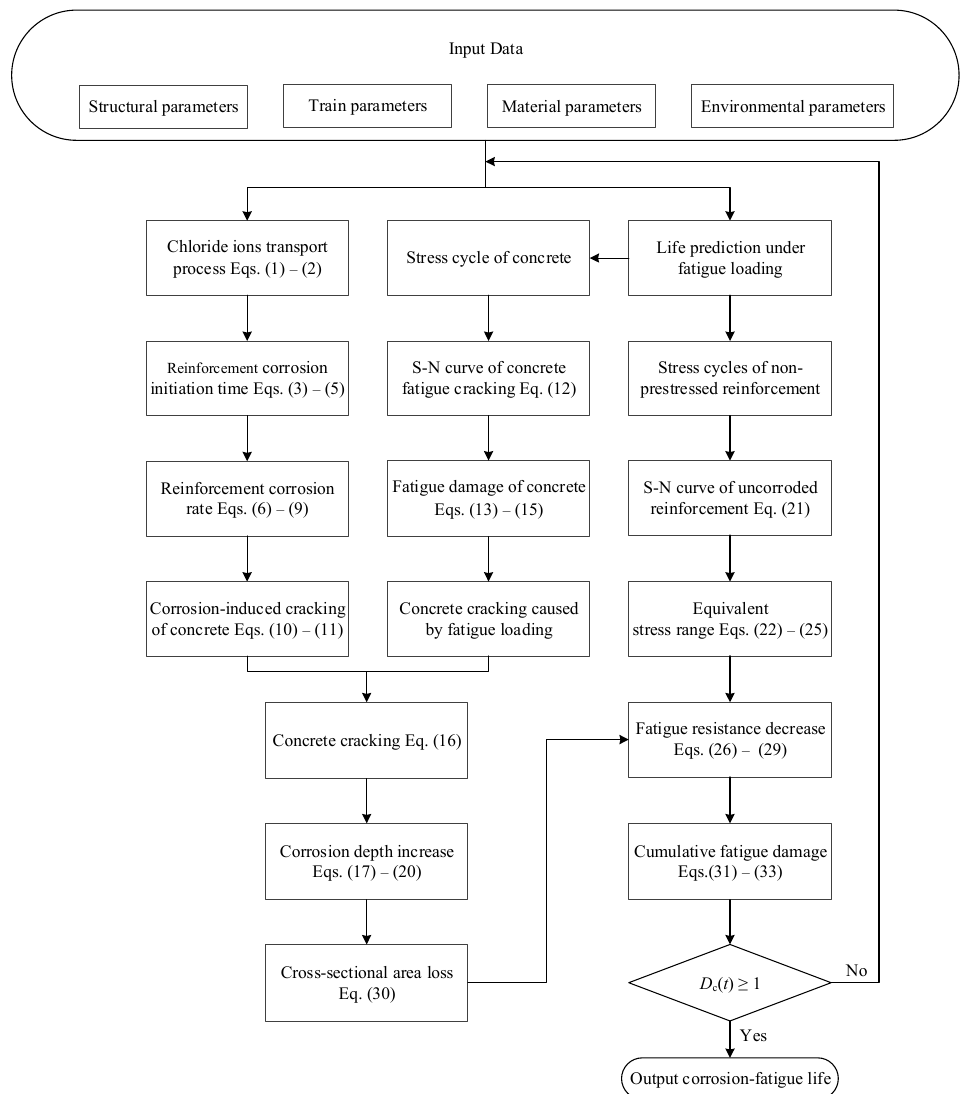
Figure 2. Corrosion-fatigue life prediction process of PC structures.